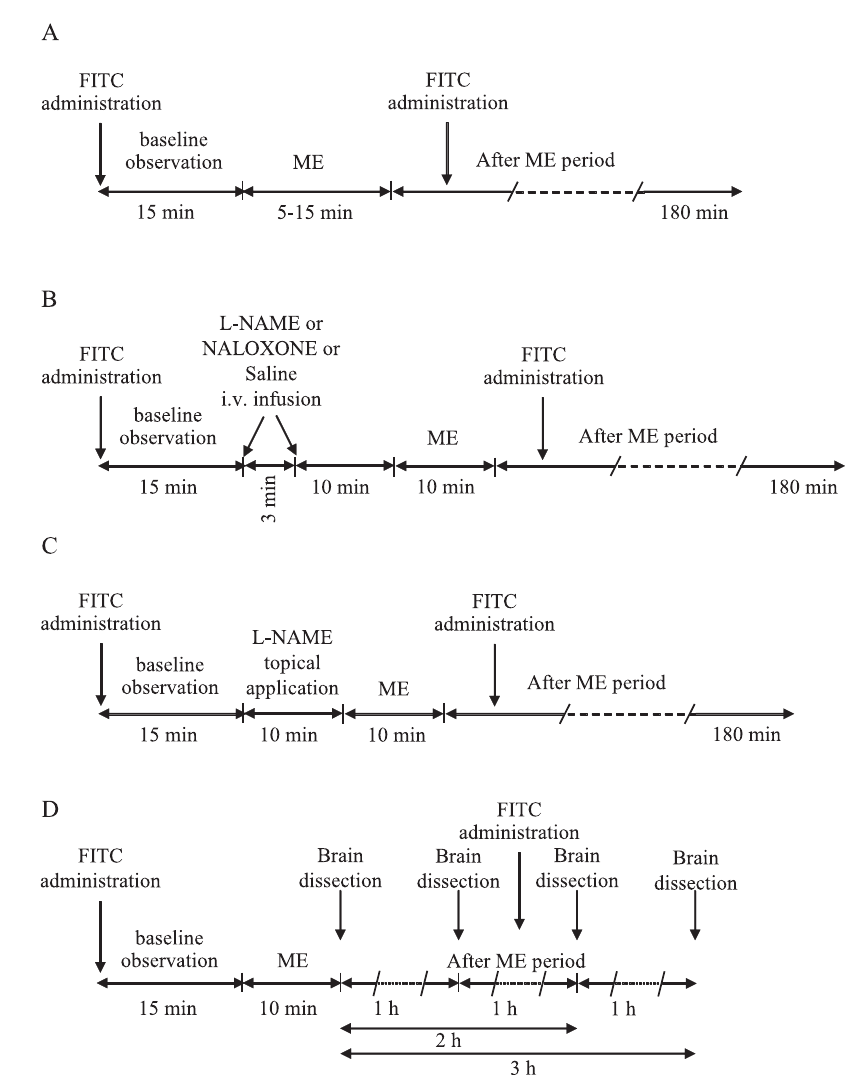
Fig. 1. Outline of the different protocols used. (A) After 15 minutes of observation in baseline conditions, 5 or 10 or 15 minutes ME were performed and after removing ME post treatment measurements were carried out for 180 minutes. At the start of the experiment and about 100 minutes later, the fluorescent tracer was infused by the catheter placed in the right femoral vein. (B) After the 15 minutes baseline observation, L- NAME or naloxone or saline were i.v. infused by the catheter placed in the right femoral vein for 3 minutes. Then, after further 10 minutes in which the animal was kept in baseline conditions, ME was applied for 10 minutes. Afterwards post treatment measurements were carried out for 180 minutes. The FITC has been infused as in A. (C) 15 minutes of baseline observation were followed by a perfusion of L-NAME for 10 minutes in the cranial window open on the parietal region. Then, 10 minutes ME was performed followed by post treatment measurements for 180 minutes. The FITC has been infused as in A. (D) All animals were subjected to 15 minutes baseline observation and 10 minutes ME. At the end of the baseline period 3 rats were sacrificed for qRT-PCR and 3 rats for Western Blotting assays (Basal in Fig. 6D, 6E). Immediately after removing ME, 3 rats were sacrificed for qRT-PCR. Post treatment measurements were continued, and after 1 hour, 3 rats were sacrificed for qRT-PCR assay, after 2 hours 3 rats were sacrificed for qRT-PCR assay and 3 rats for Western Blotting assay, and after 3 hours further 3 rats were sacrificed for qRT-PCR assay. FITC was initially infused in all animals and every 100 minutes in the animals observed for prolonged